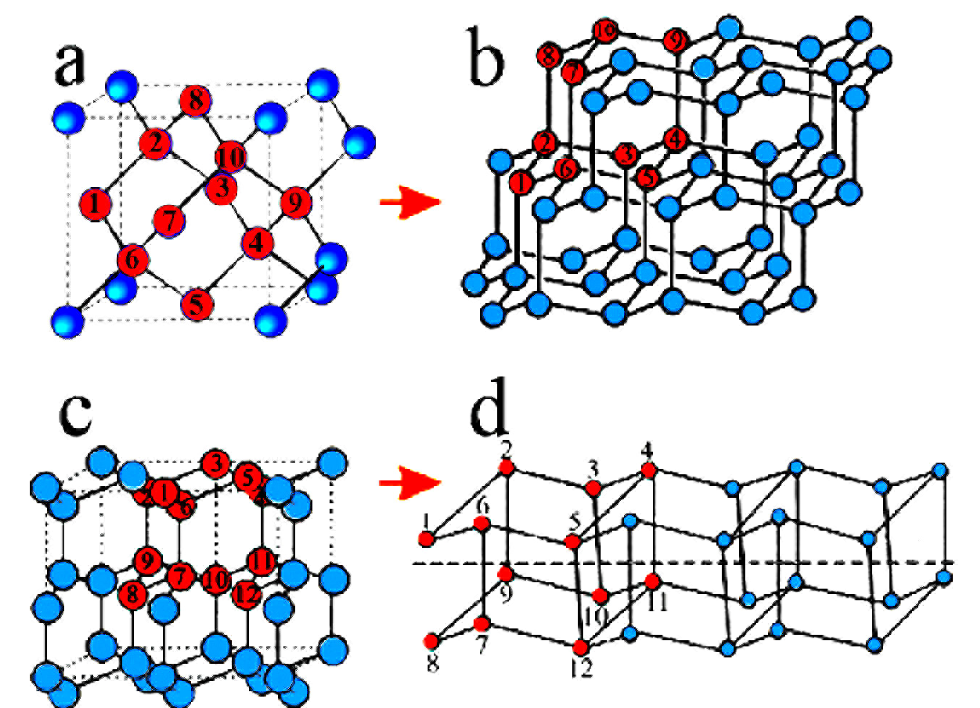
Figure 4. Multiplication of building blocks of diamond. a) Unit cell of cubic diamond with two interpenetrating face-centered cubic lattices. b) Multiplication of C10 (adamantane) units forming cubic diamond. c) Unit cell structure of hexagonal lattice. d) C12 building blocks multiplicated to form hexagonal